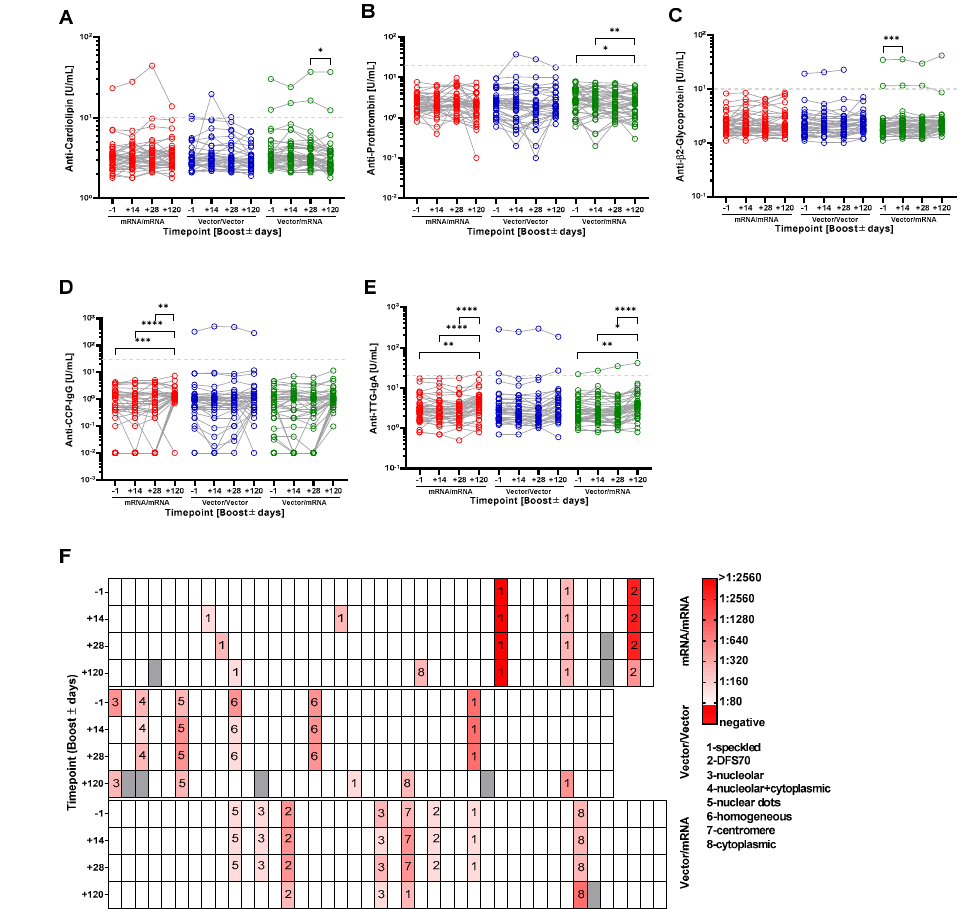
Figure 3. Analysis of autoantibody levels in the serum of the participants at the different time points and in the different groups (red-mRNA/mRNA; blue-Vector/Vector; green-Vector/mRNA). Connected circles represent the antibody levels of an individual participant. ( A ) anti-Cardiolipin; ( B ) anti-Prothrombin; ( C ) anti- β 2-Glycoprotein; ( D ) anti-CCP; ( E ) anti-TTG autoantibody levels in the indicated groups. ( F ) Analysis of ANAs in serum samples of the shown groups. Color of the boxes indicate individual titers and numbers state the respective patterns. Statistical analyses by Mixed-effects analysis with Tukey’s multiple comparison test within and between groups ( C ). * p < 0.05, ** p < 0.01, *** p < 0.001, **** p < 0.0001.